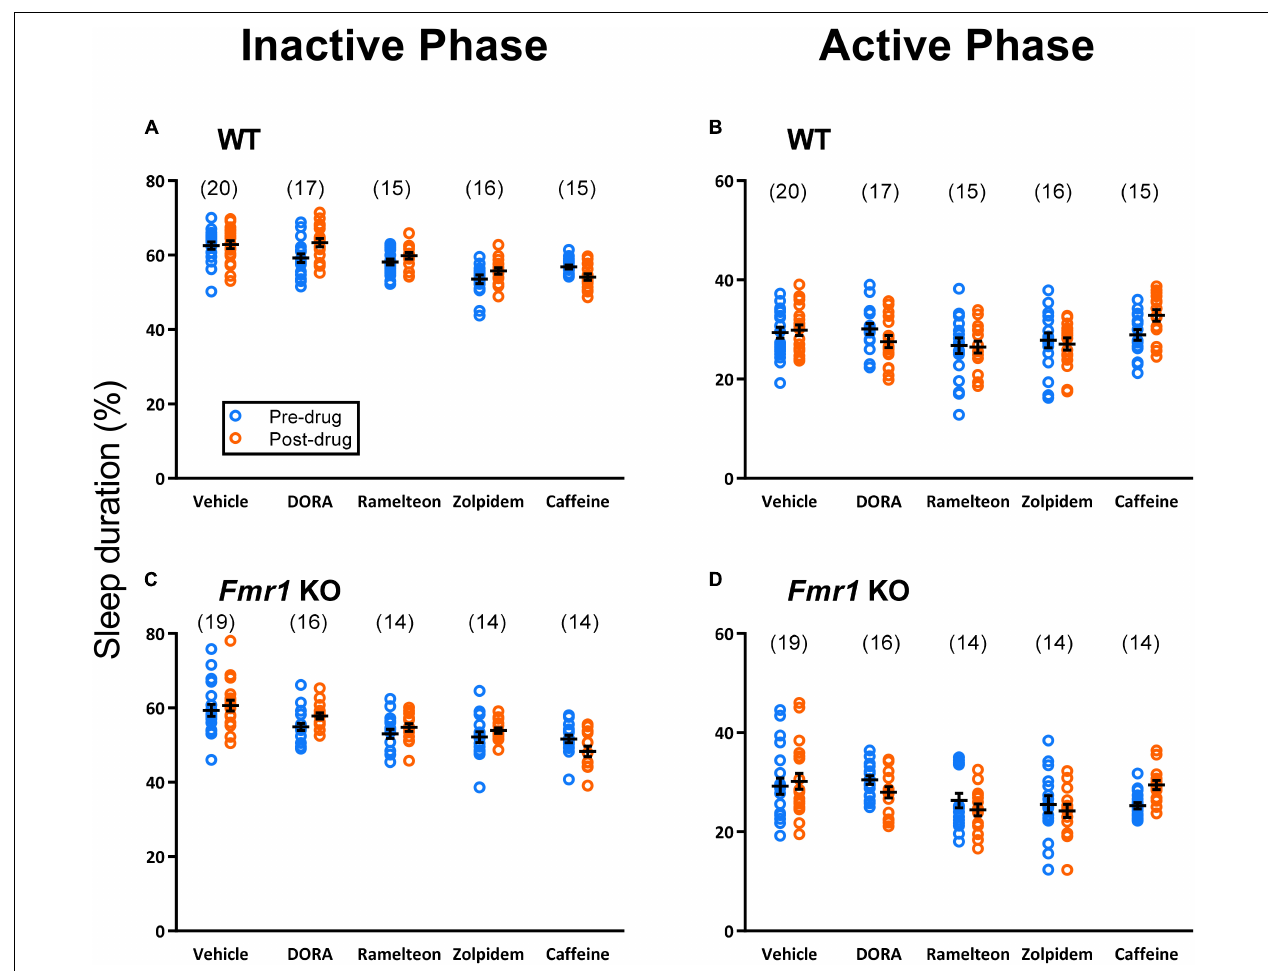
FIGURE 2 | Sleep duration was analyzed employing a within subject design. Sleep duration on Day 3 (pre-drug) was compared with the average sleep duration for Days 4–5 (post-drug). Each point represents the value for a single animal. Lines represent means ± SEM for the number of animals indicated in parentheses. Sleep duration in the inactive phase (A,C) showed a statistically significant treatment × day interaction for both the hypnotics ( p < 0.001) and caffeine analyses ( p < 0.001). Post-hoc t -tests showed that, regardless of genotype, DORA-22 (7 ± 1% (mean ± SEM of individual percent changes), p < 0.001), ramelteon (4 ± 1%, p = 0.003), and zolpidem (4 ± 1%, p = 0.001) significantly increased sleep duration compared to pre-drug. Caffeine significantly decreased sleep duration compared to pre-drug ( − 5 ± 2%, p < 0.001). Sleep duration in the active phase (B,D) also showed a significant treatment × day interaction for both the hypnotics ( p < 0.001) and caffeine analyses ( p = 0.008). P ost-hoc t -tests showed that DORA-22 ( − 8 ± 2%, p < 0.001) and zolpidem ( − 3 ± 3%, p = 0.046) significantly decreased sleep duration in the active phase, whereas caffeine (17 ± 2%, p < 0.001) significantly increased sleep duration in the active phase. Ramelteon tended to decrease sleep duration in the active phase ( − 2 ± 3%, p =